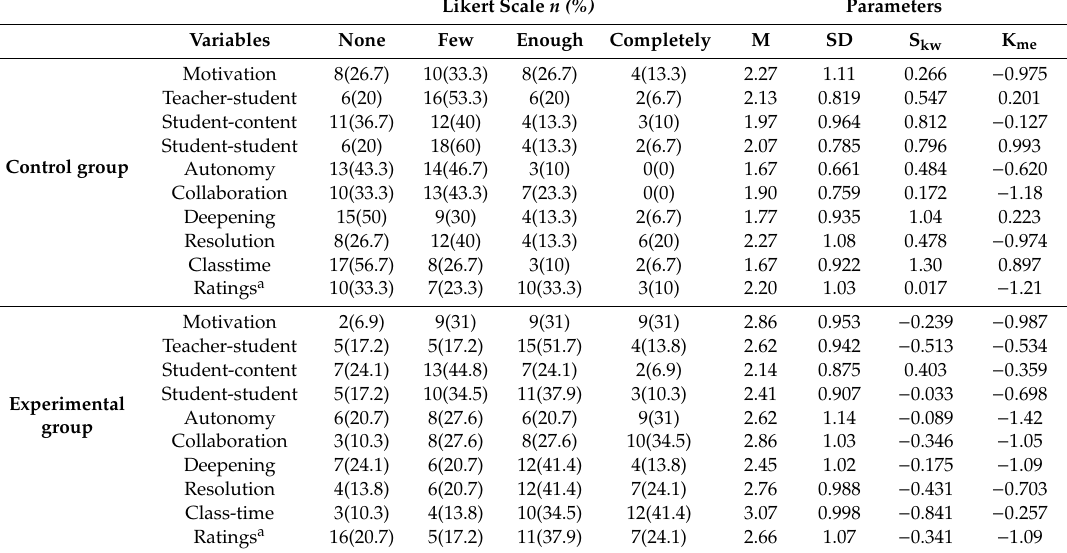
Table 2. Results of the study variables in both groups (control and experimental) from the parameters of the mean (M), standard deviation (SD), skewness (S kw ), and kurtosis (K me